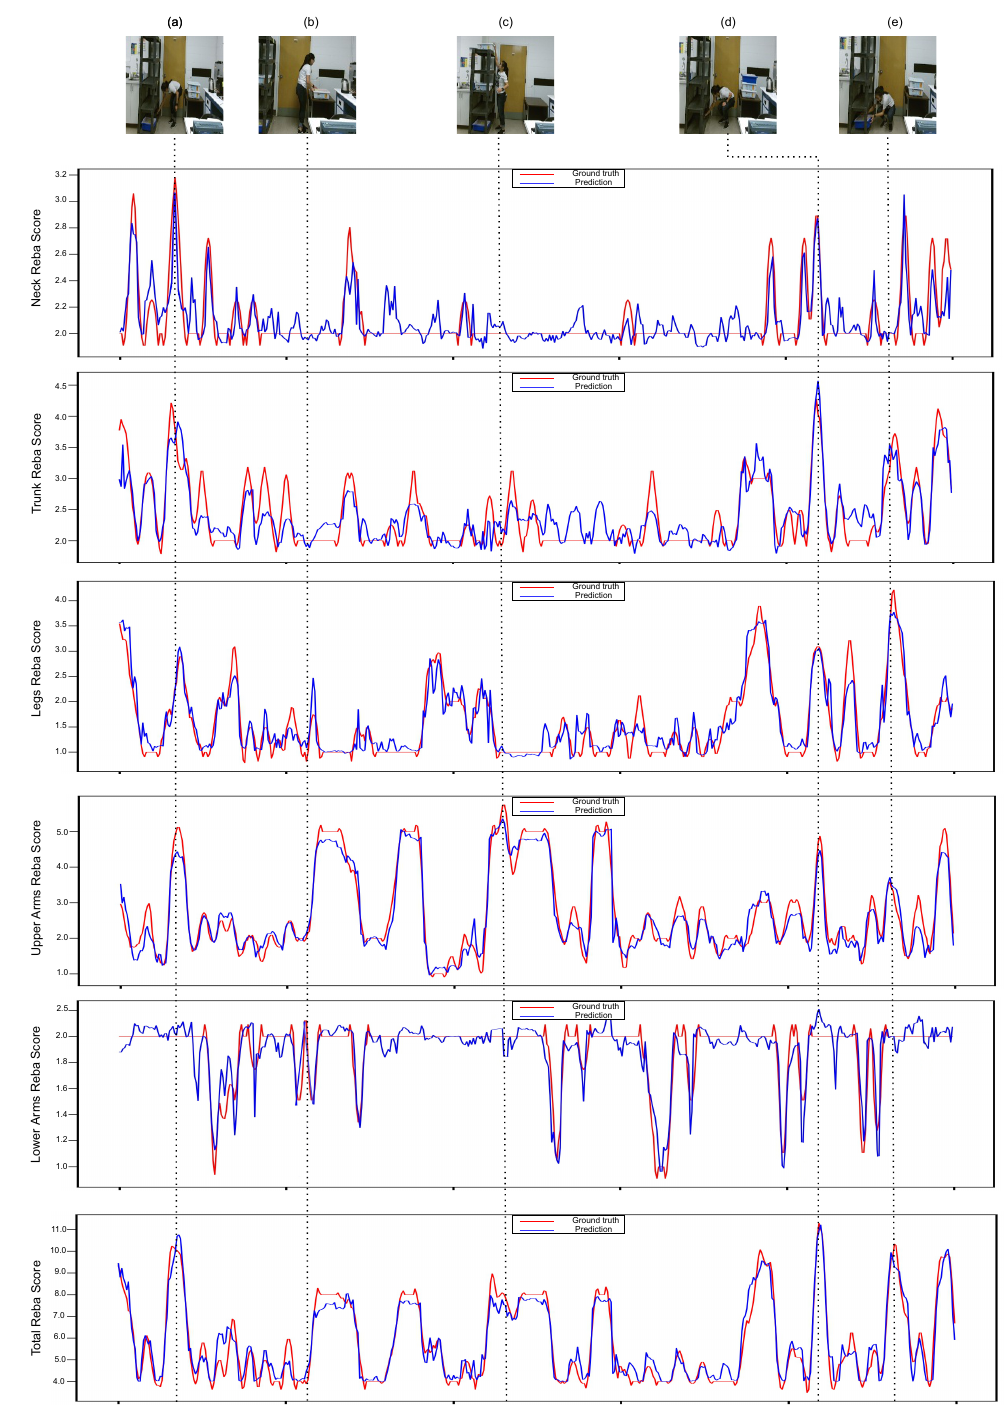
Figure 3. Visualization of ground truth (red lines) and predicted (blue lines) partial and total REBA scores on a video sequence from the UW-IOM dataset. At the top, five frames ( a – e ) that correspond to extreme postures with high ergonomic risks are displayed, while REBA scores for individual body parts and the whole body